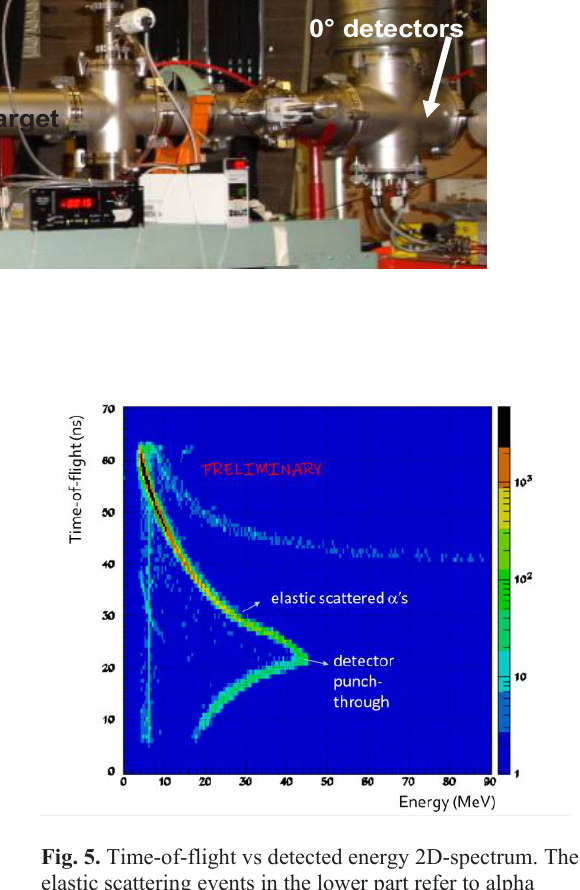
Fig. 5. Time-of-flight vs detected energy 2D-spectrum. The elastic scattering events in the lower part refer to alpha particles scattered close to the entrance